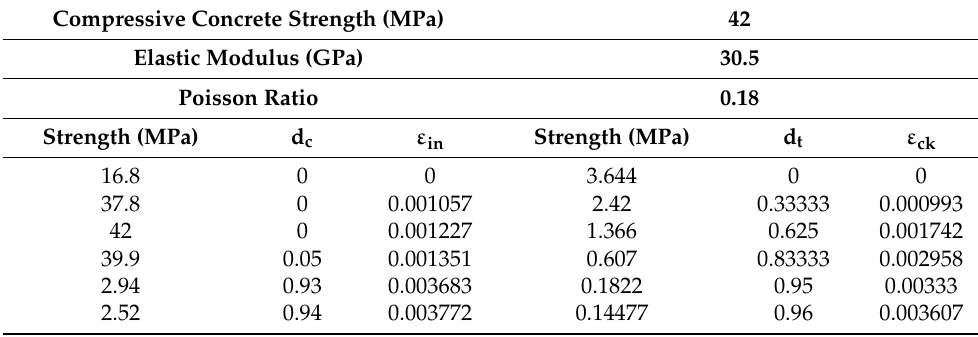
Table 4. Properties of NSC along with CDP model parameters in compression and tension in the shear test.